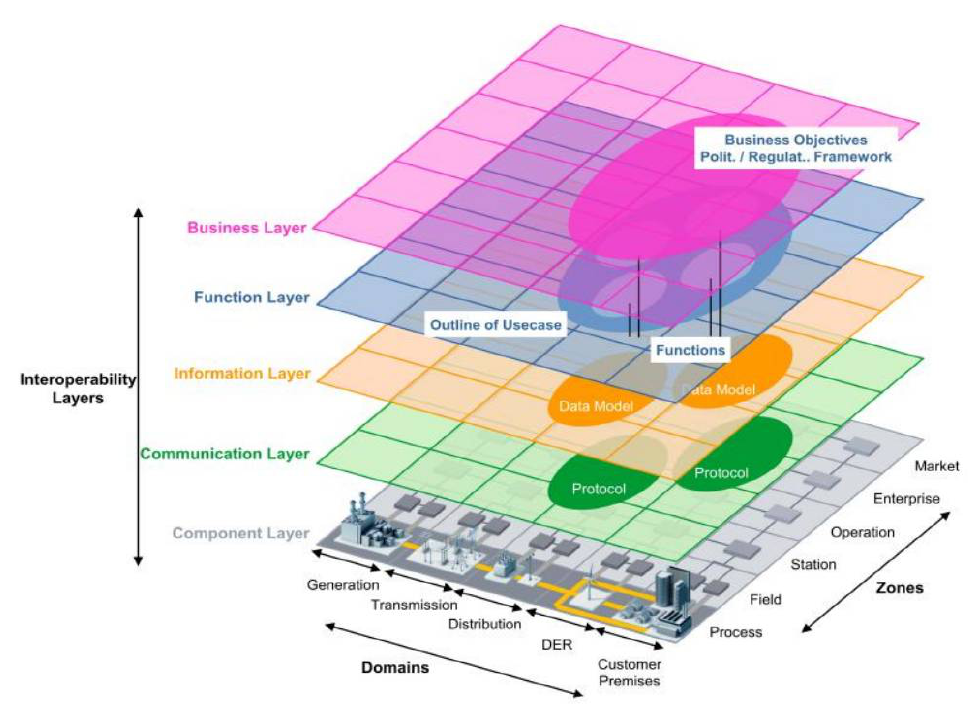
Figure 1. SGAM Framework (SG-CG/M490/K, 2014).